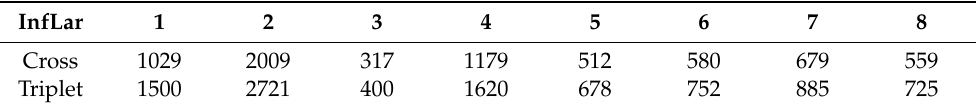
Table 4. Computation time for training a single Siamese network, each column reports the computa- tion time of a given topology network, numbered 1–8 (topologies are described in [14] and reprinted in the Appendix